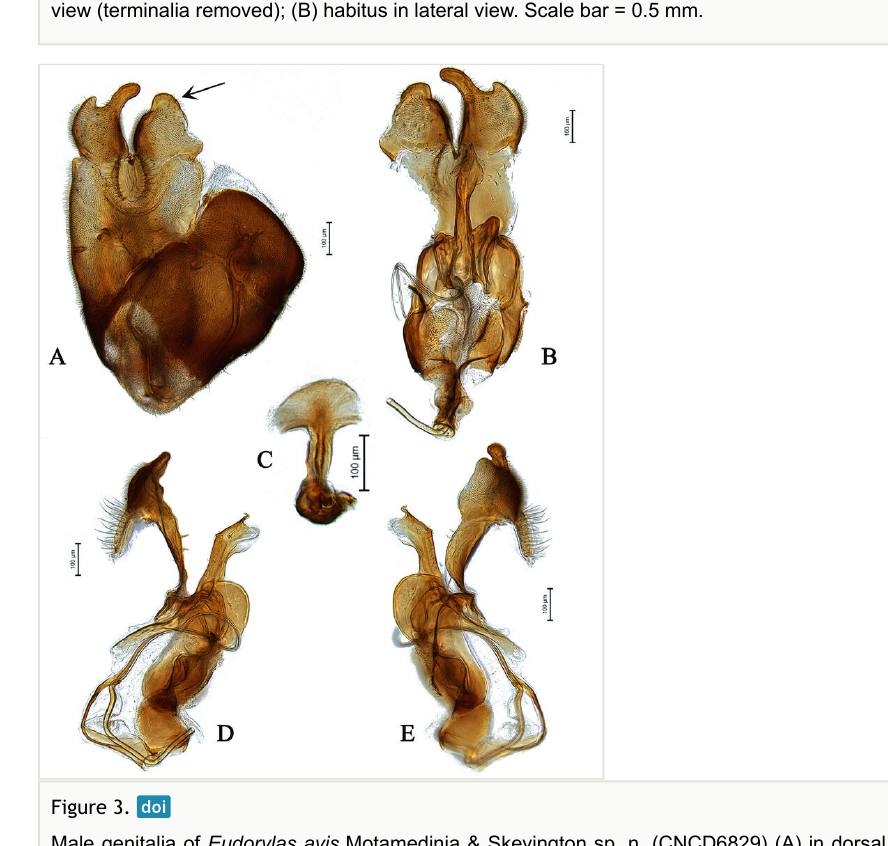
Male genitalia of Eudorylas avis Motamedinia & Skevington sp. n. (CNCD6829) (A) in dorsal view; (B) in ventral view; (C) ejaculatory apodeme; (D, E) in lateral